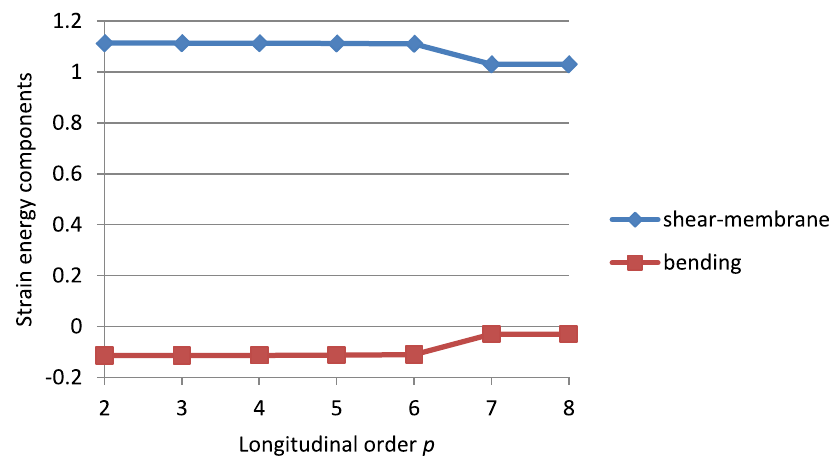
Figure 7. The sum of local energies—the membrane-dominated shell.